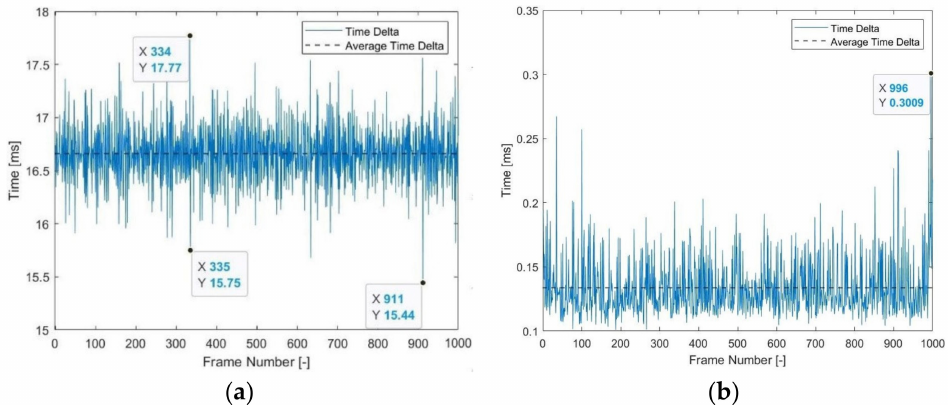
Figure 11. Screen synchronisation: ( a ) Delta between successive refreshes according to beam position timestamp; ( b ) Time difference between requested and returned VBI timestamp.